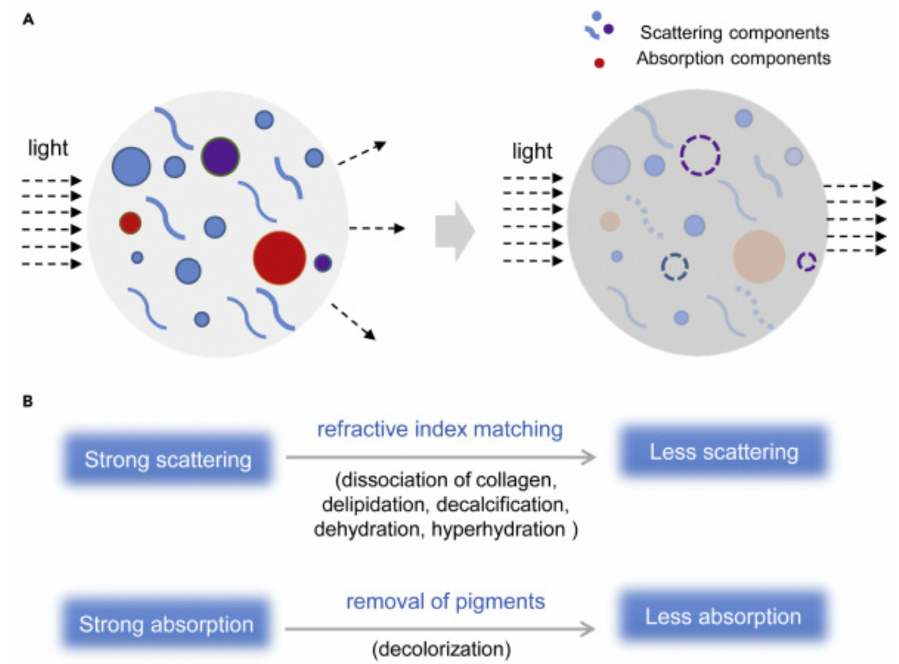
Figure 2. ( A ) Scheme presenting basic physicochemical mechanisms of TOC. ( B ) TOC relies mainly on the reduction of light scattering (achievable though delipidation, dehydration or hy-perhydration, decalcification and dissociation of collagen fibers) and absorption. Reproduced from Yu et al. [25] under the terms of CC BY-NC-ND 4.0